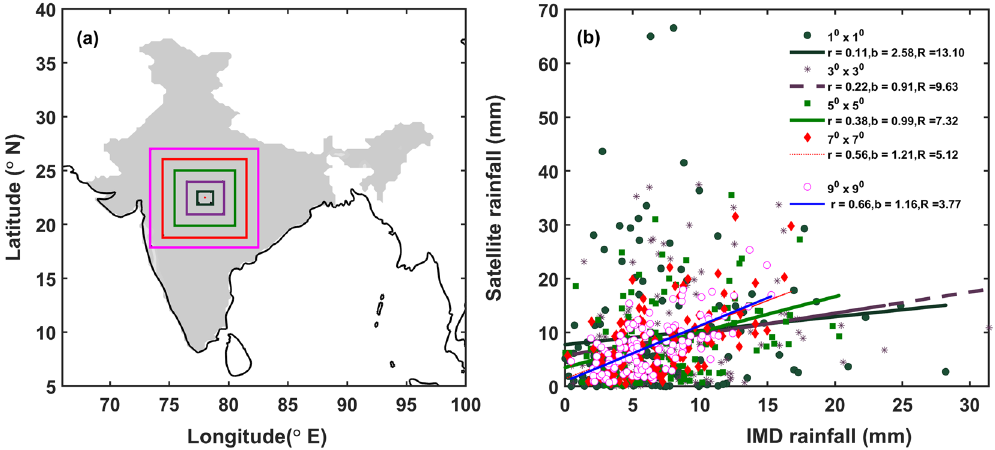
Figure 1. Region of spatial assessment over India ( a ) and distribution of IMD and IMERG rainfall at different spatial scale ( b ) [r (correlation), b (bias/mm), R